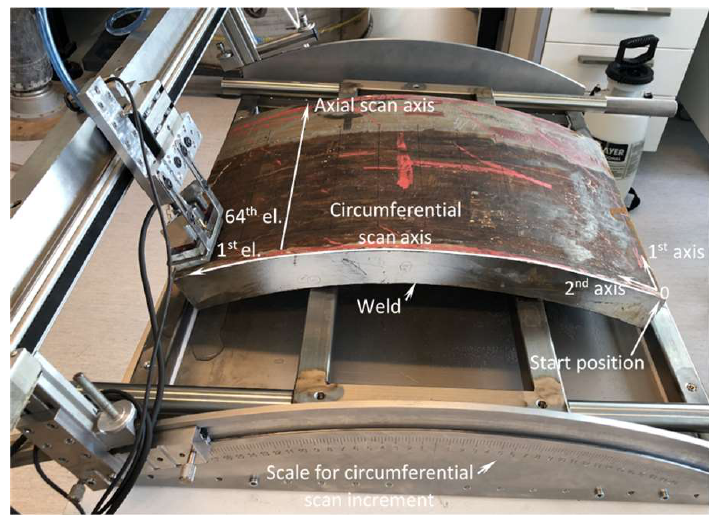
Figure 2. Experimental set-up for full surface TFM data acquisition. Table 2. Circumferential and axial scan lengths for each test piece under inspection. Test Piece Reference